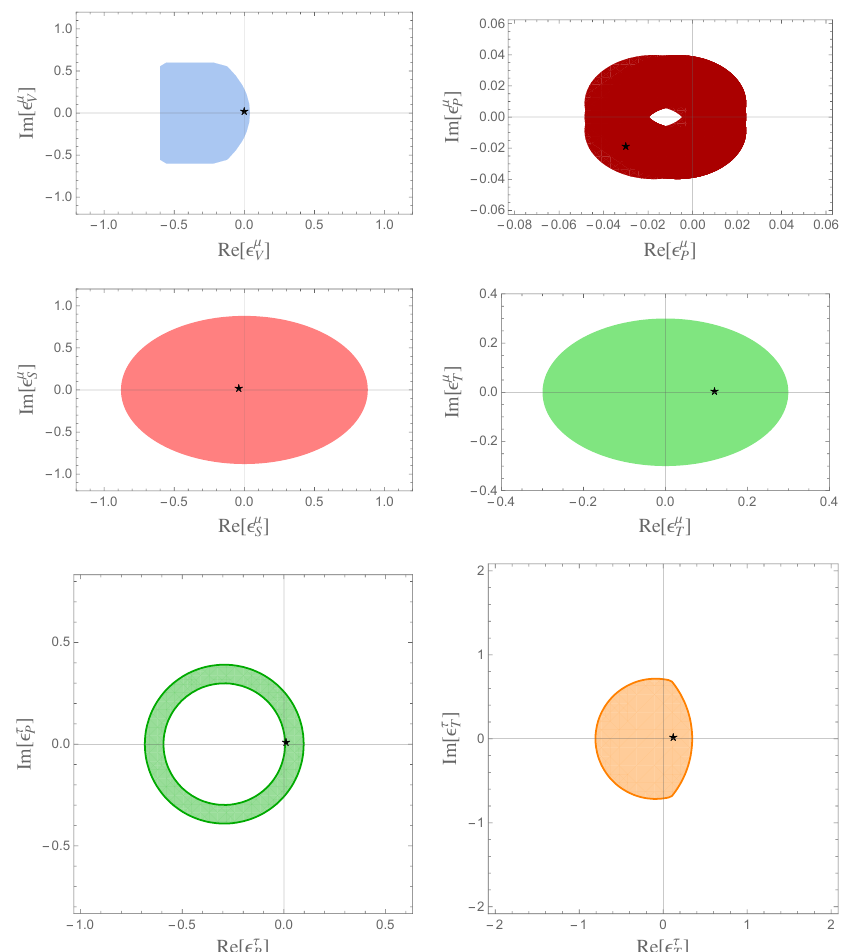
Figure 2. Allowed regions (at 68% CL) for the couplings (cid:101) µ (second row plots). The stars are the benchmark points: ( Re [ (cid:101) µ ( − 0.03, − 0.02 ) , ( Re [ (cid:101) µ 10 − 3 . The plots in the third row show the allowed regions for the couplings (cid:101) τ indicating the benchmark points (cid:101) τ ( 0.12, 0 ) . The various colors indicate the different